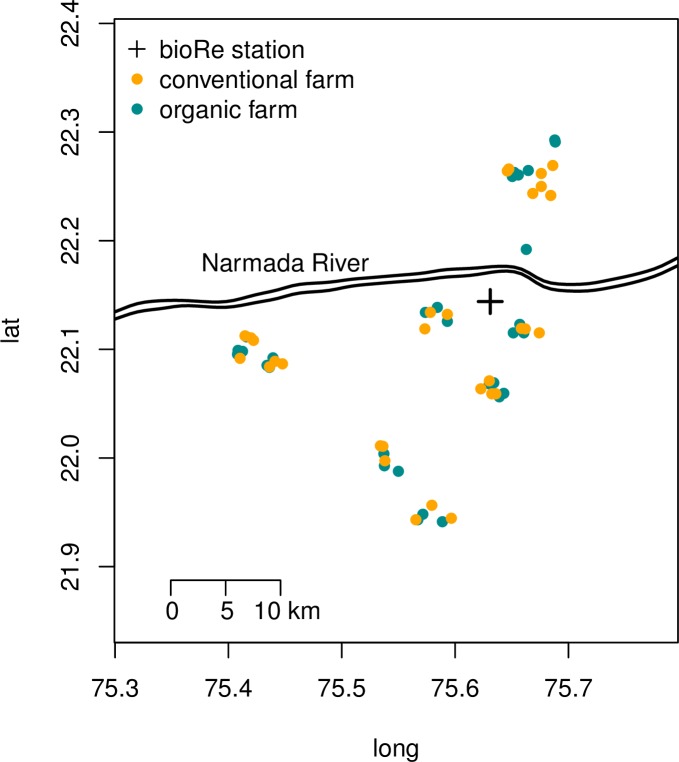
Spatial distribution of farms.Location of 30 organic and 30 conventional farms and bioRe station in study region.